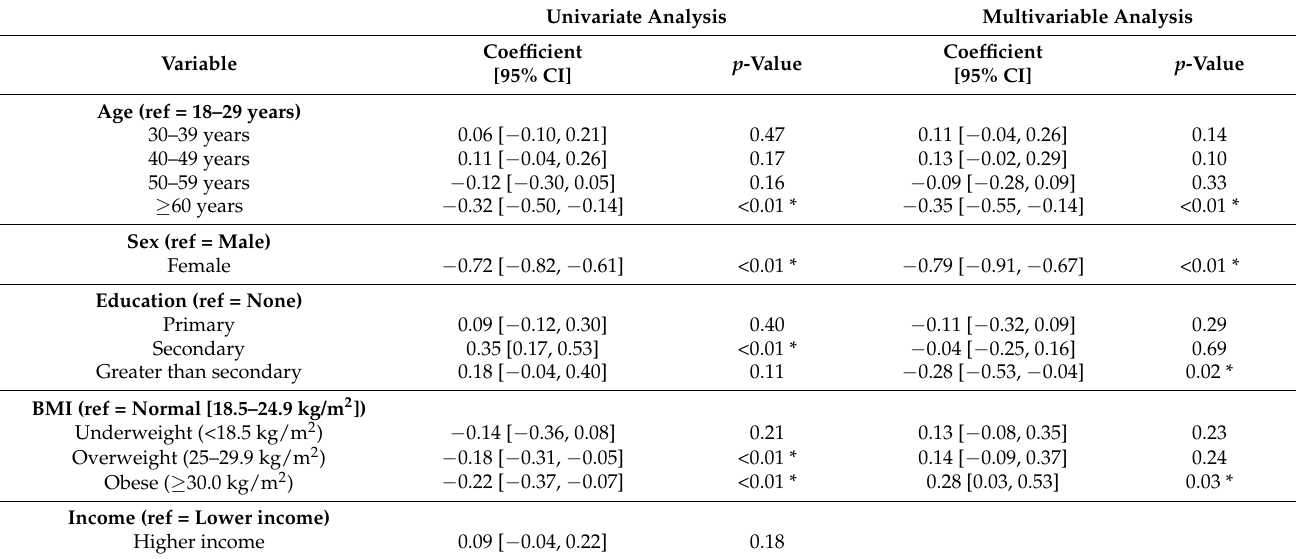
Table 6. Associations between sociodemographic characteristics and number of days per week eating meals at a street vendor among the study